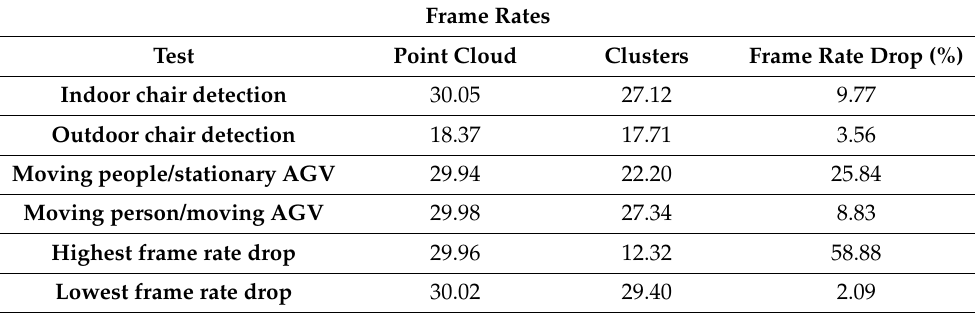
Table 5. Frame rate drops for different tests.